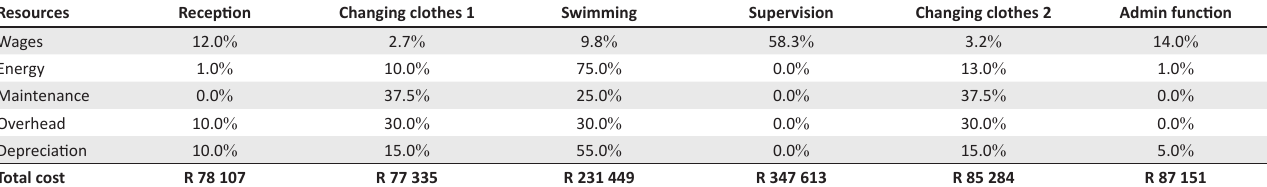
TABLE 1: Allocation of resource cost to activities. Resources Reception Changing clothes 1